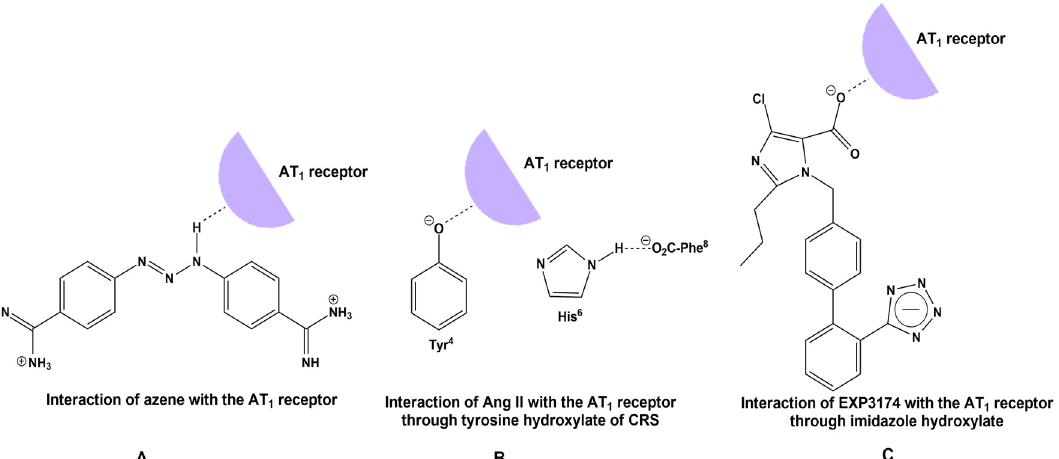
Figure 8. ( A ) Hypothetical interaction between azene and the receptor paralleled with the interac- tion of tyrosine hydroxylate of AngII. ( B ) Interaction of AngII with the receptor through CRS. A charge relay system of AngII demonstrates the interaction between the Tyr 4 and His 6 side chains and the C-terminal carboxylate of AngII and results in tyrosinate formation and receptor activation [82] . ( C ) Mechanism of action of Angiotensin II antagonist EXP3174 with its receptor [83] . 4.5. The Amphoteric Nature of DIZE May Allow Binding to Acidic and Basic Sites of SARS-